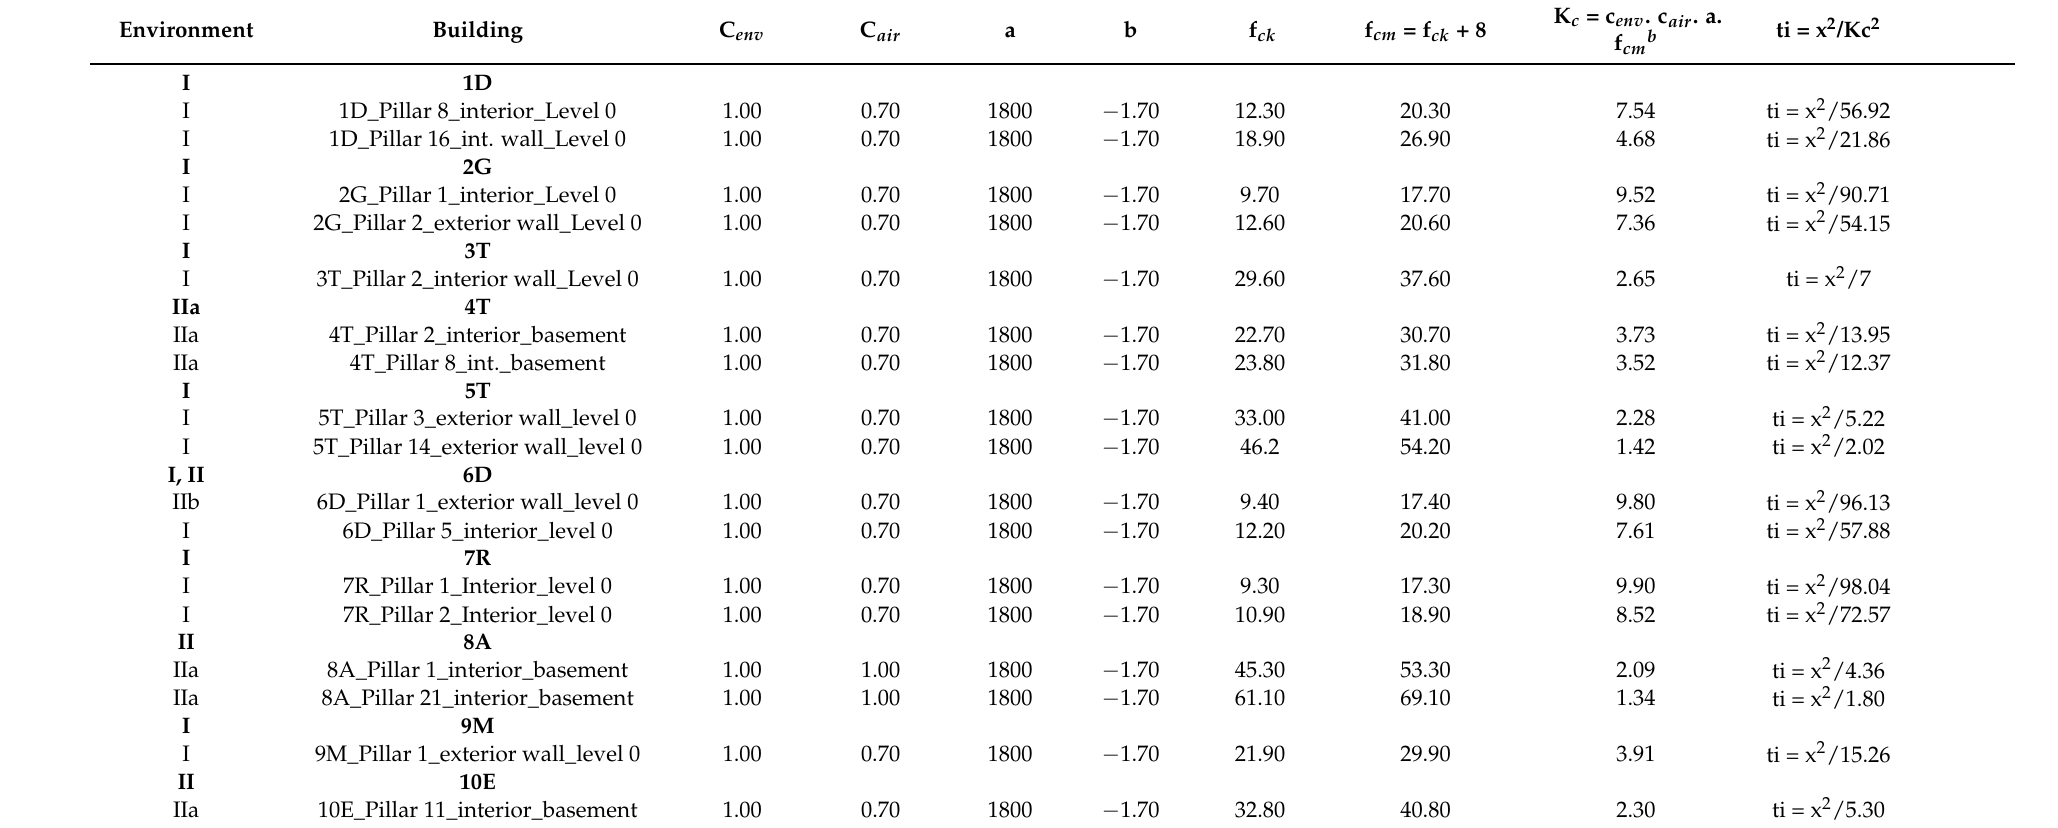
Table 3. Model of the corrosion initiation period of each